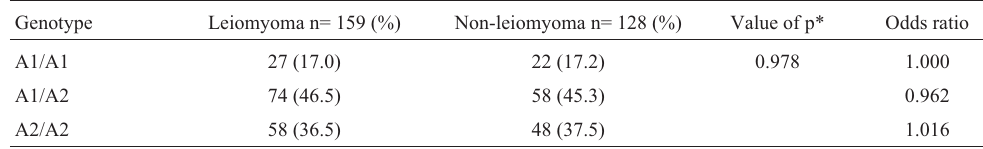
Table I - Frequency distribution of CYP17 gene polymorphism in women with and without leiomyoma. Genotype